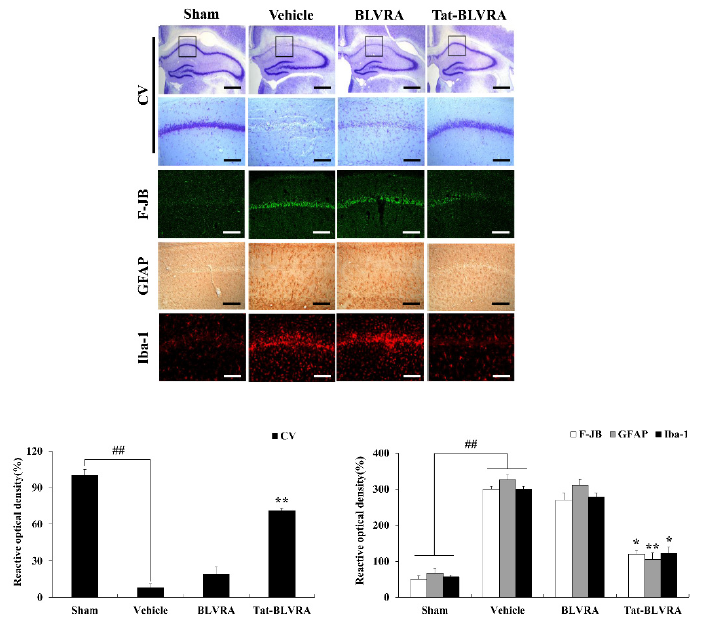
Figure 6. Effects of Tat-BLVRA protein on neuronal cell death in an animal model of ischemia. Gerbils were treated with a single injection of Tat-BLVRA and control BLVRA protein (2 mg/kg) before ischemia-reperfusion and sacrificed after 7 days. Neuronal cell viability was analyzed by cresyl violet (CV), fluoro-Jade B (F-JB), ionized calcium-binding adaptor molecule 1 (Iba-1), and glial fibrillary acidic protein (GFAP) immunostaining. Relative numeric analysis of CV-, F-JB-, Iba-1-, GFAP-positive neurons in the CA1 region is shown. Scale bar = 18.8 µm and 50 µm. ** p < 0.01 significantly different from the vehicle group. ## p < 0.01 significantly different from the sham group.